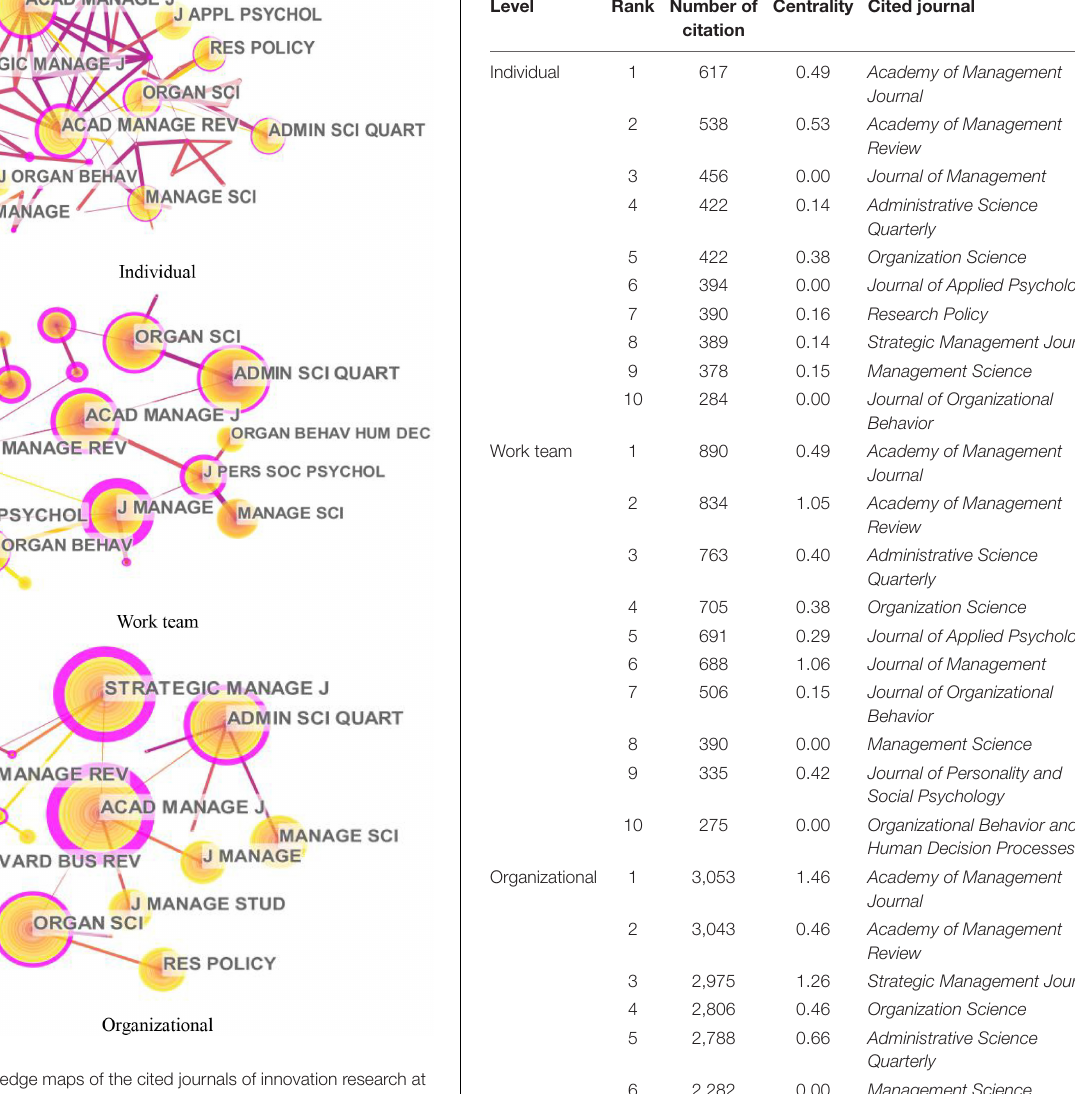
FIGURE 4 | Knowledge maps of the cited journals of innovation research at different levels.